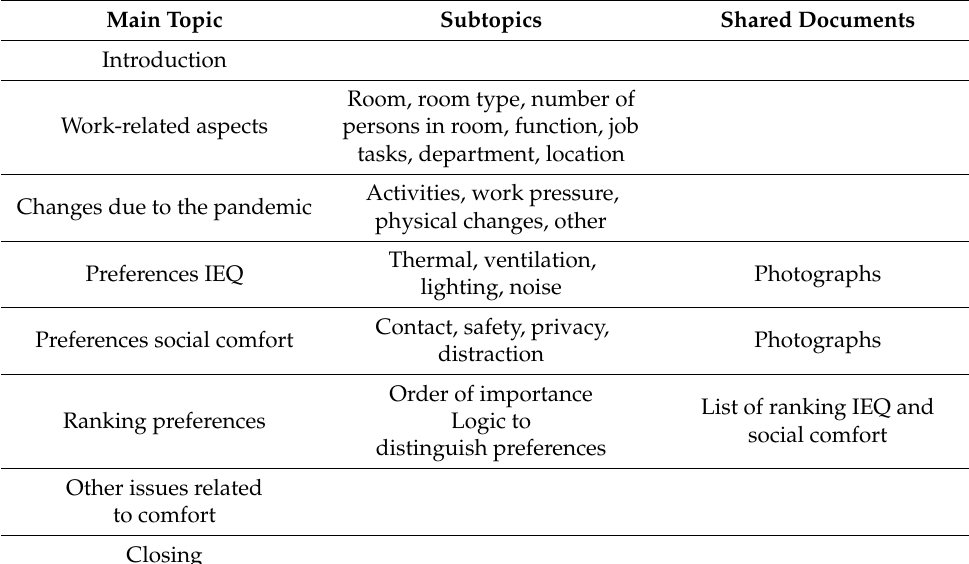
Table 1. Topic guide semi-structured